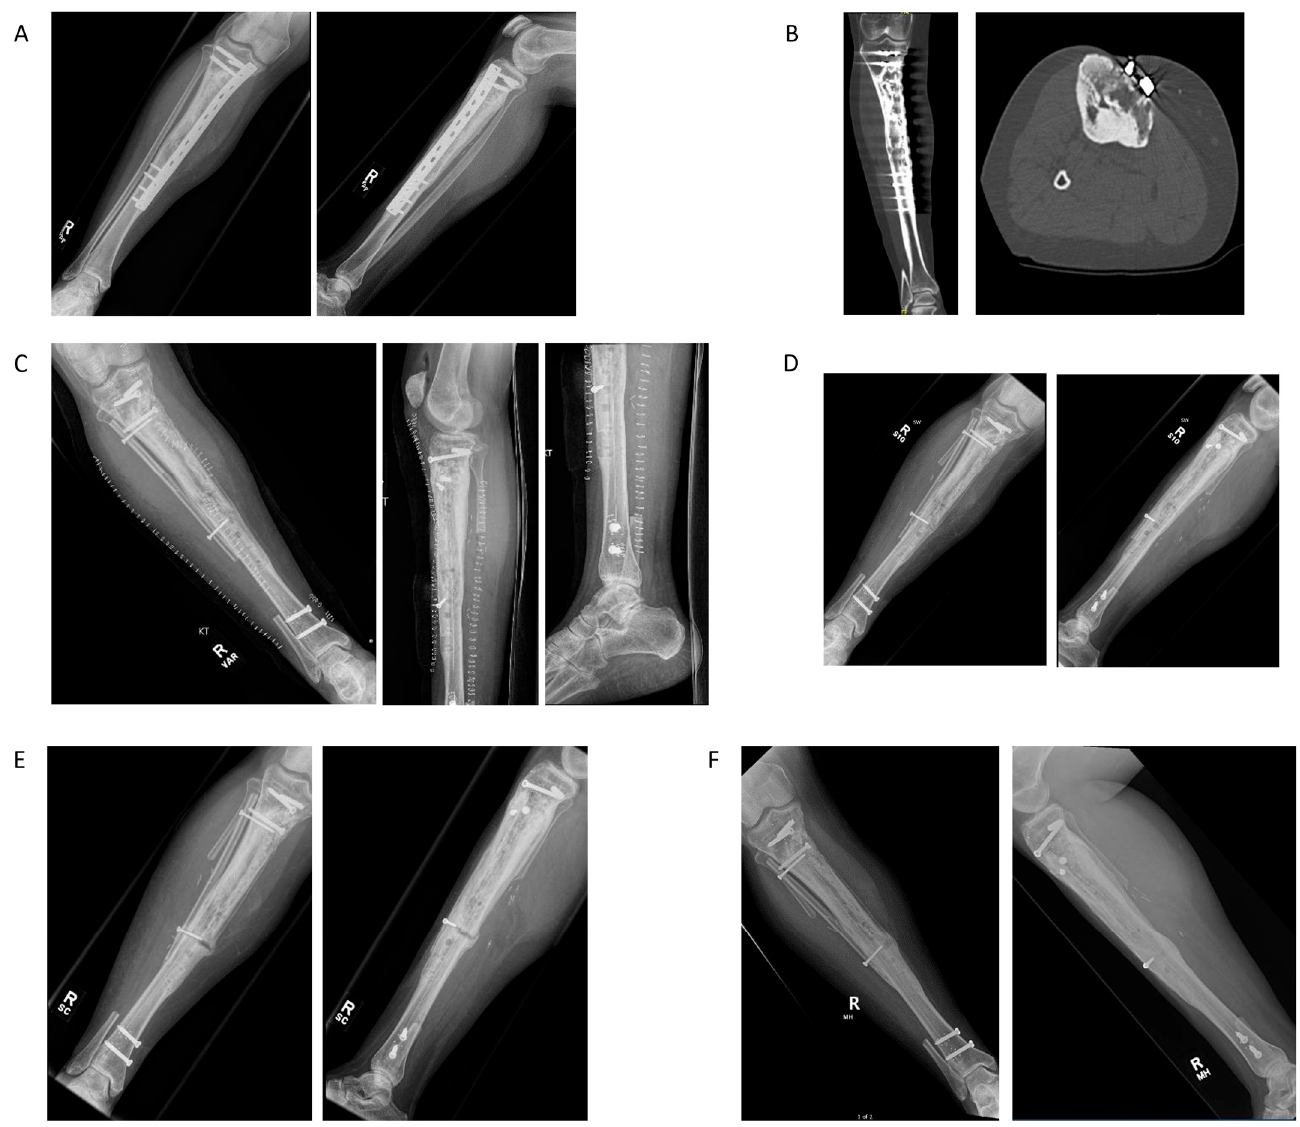
Figure 6. ( A ) Pre-operative AP and lateral radiographs demonstrating prior segmental resection of the proximal right tibia with allograft secured with a medial plate and multiple screws. ( B ) Pre-operative coronal and axial computed tomography (CT) images demonstrating potential hardware failure and concern for allograft fracture. ( C ) Immediate post-operative AP and lateral radiographs showing carbon fiber intramedullary rod in place and transposed vascularized fibular autograft secured with two screws. Note is made of one broken screw fragment from her prior operation that was retained in the proximal tibia. ( D ) AP and lateral radiographs 4-months post-operatively demonstrating a new unicortical allograft fracture after mechanical fall. ( E ) AP and lateral radiographs 8-months post-operatively bridging callus at the site of the mid-tibial unicortical allograft fracture. ( F ) AP and lateral radiographs 2-years post-operatively showing healed mid-tibial unicortical allograft fracture. 4 months after surgery, she sustained a mechanical fall. A unicortical fracture at the allograft and host bone interface was identified on radiographs without evidence